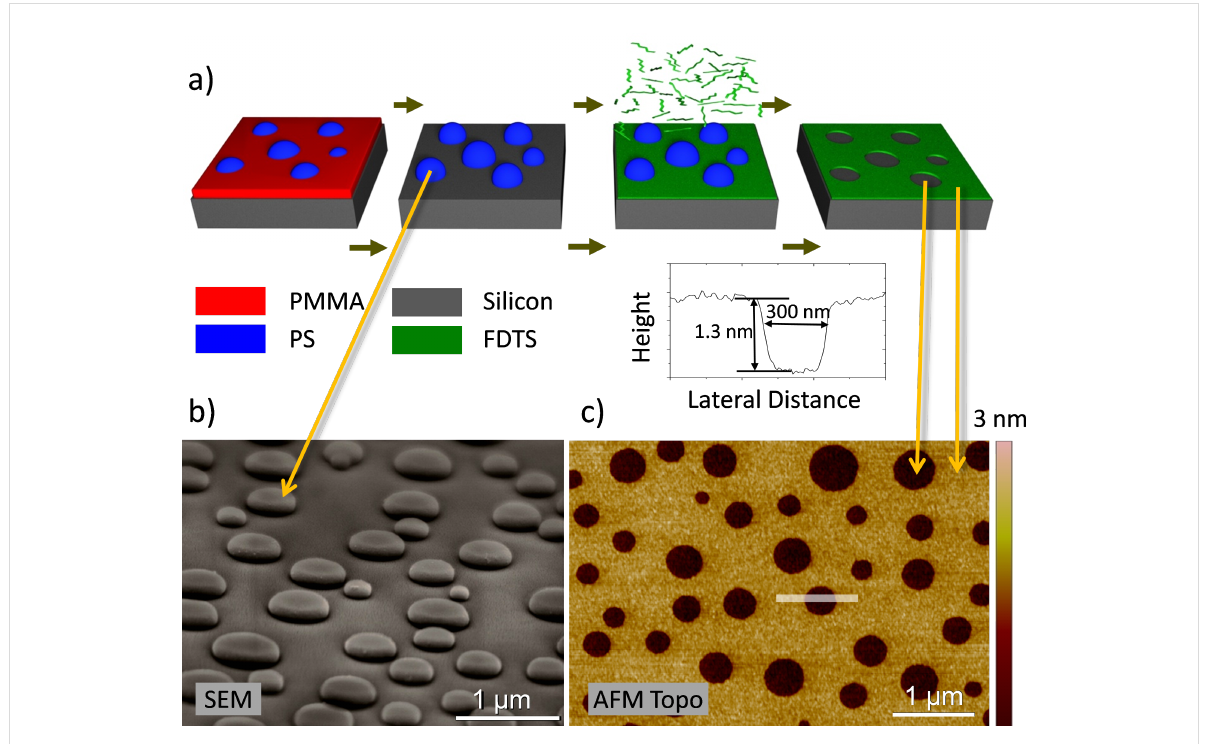
Figure 3: Fabrication of a two-phase SAM template spin-cast at a humidity of 45%. (a) Schematic drawing of the process, silicon substrate (grey), PMMA (red), PS (blue) and FDTS (green). (b) SEM image of a polymer blend mask rinsed with acetic acid. (c) AFM image (retrace image measured in contact mode in liquid) of a two-phase SAM template. The cross section demonstrated is the average of the trace and the retrace images. The depth of the holes is 1.3 nm, independent of the intensity and the duration of the snow-jet treatment.